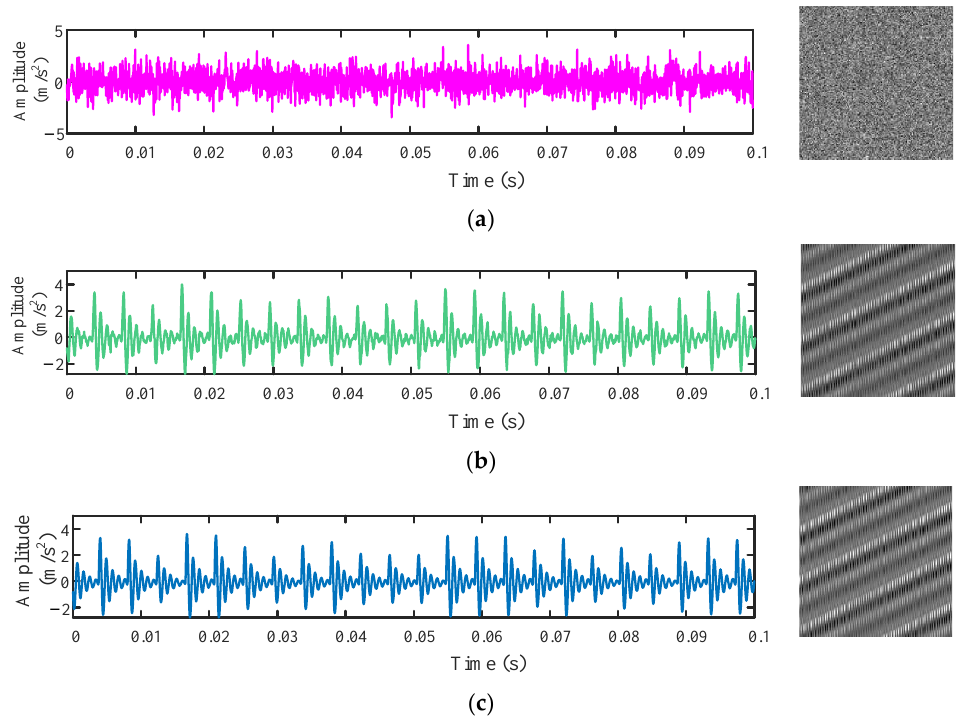
Figure 6. TA-UNet noise reduction results for simulation signal with SNR = −4 5 dB. ( a ) Simulation signal with SNR = −4 5 dB; ( b ) Noise reduction results of simulation signal by TA-UNet; ( c ) Impulse signal.